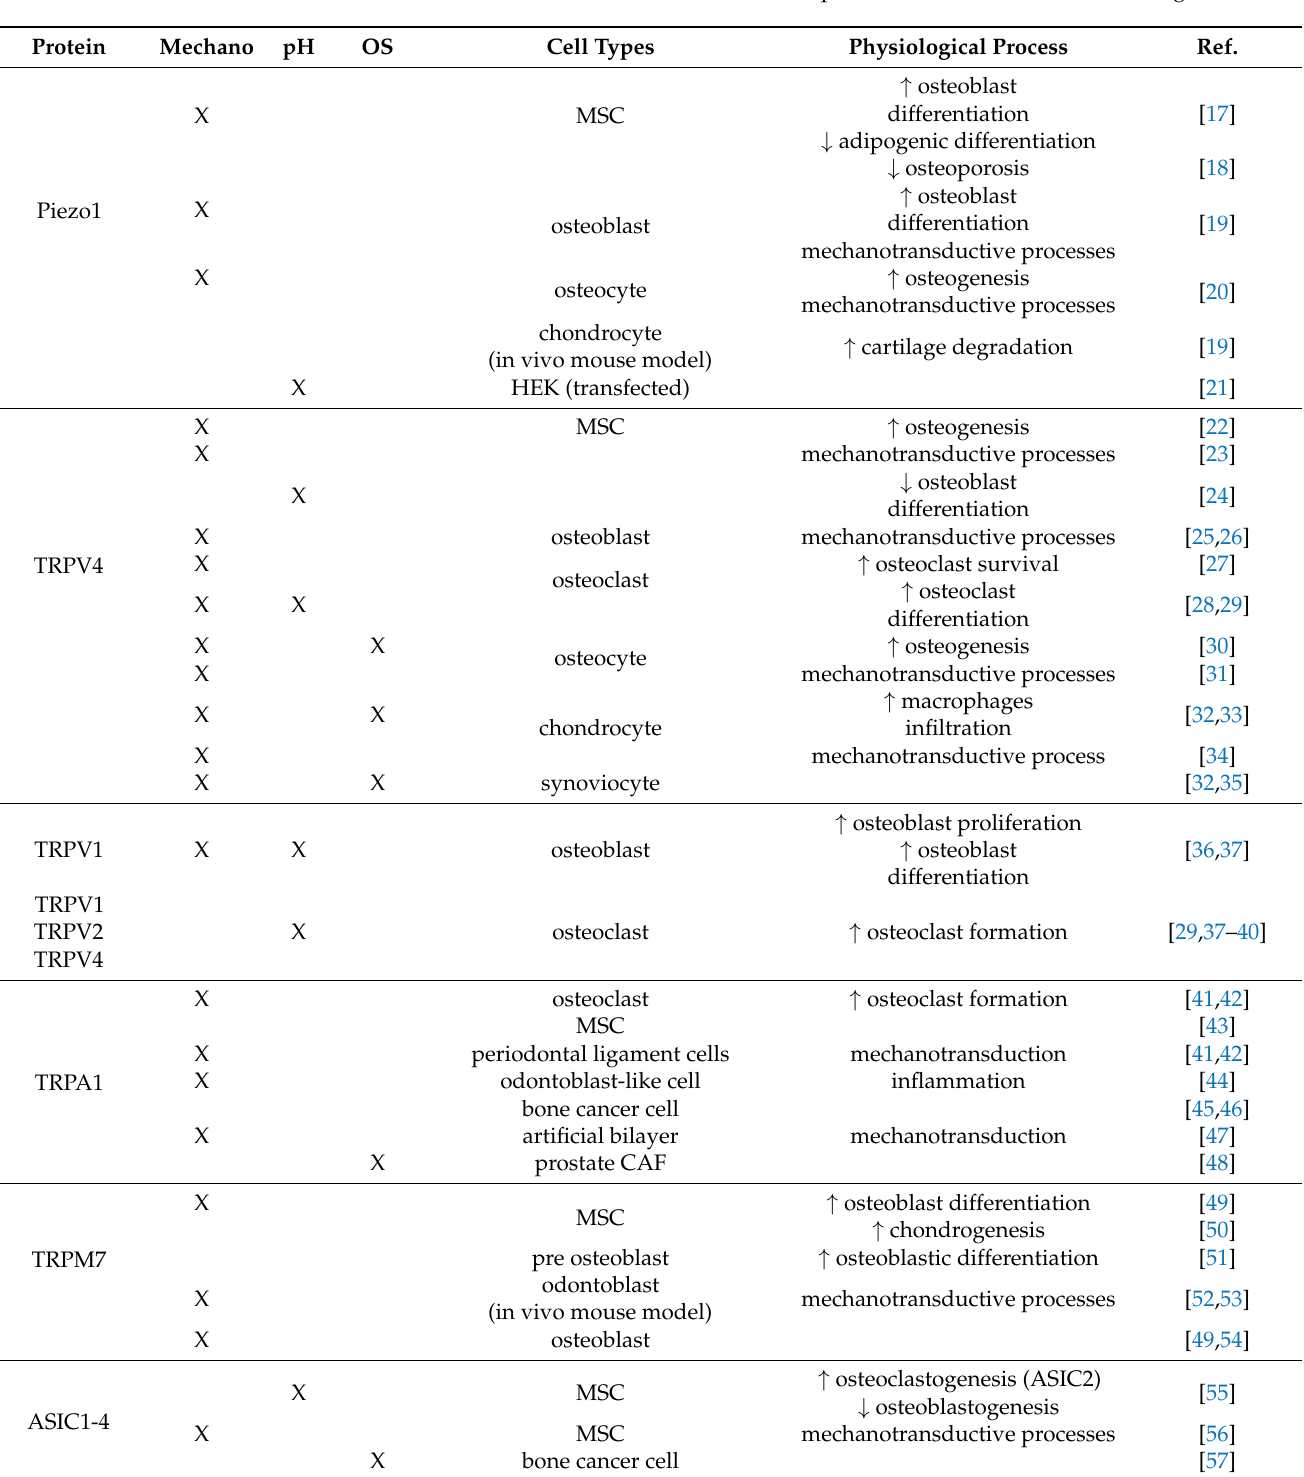
Table 1. List of the plasma membrane ion channels involved in bone remodeling and their role in physio-pathological processes; ↑ : increased, ↓ : decreased. OS: Oxidative Stress. MSC: Mesenchymal Stem Cells, CAF: Cancer Associated Fibroblasts, mpkCCDc14: mouse cortical collecting duct